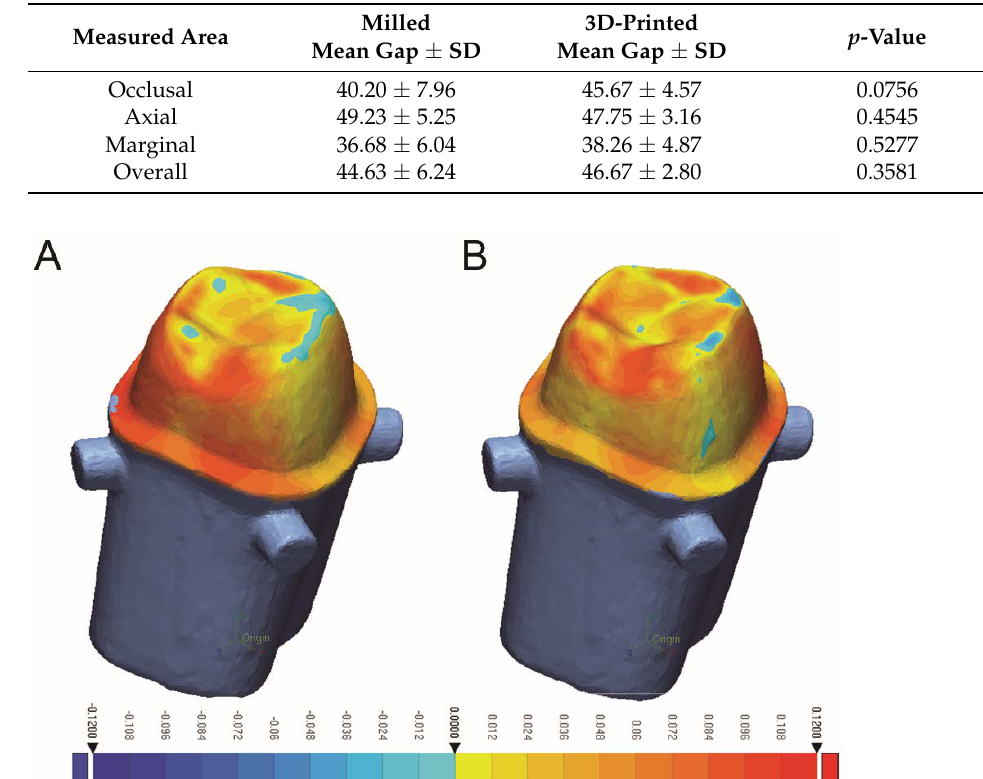
Table 2. Marginal gap and internal fit mean ± standard deviations (SD) at four different measurement areas ( µ m).